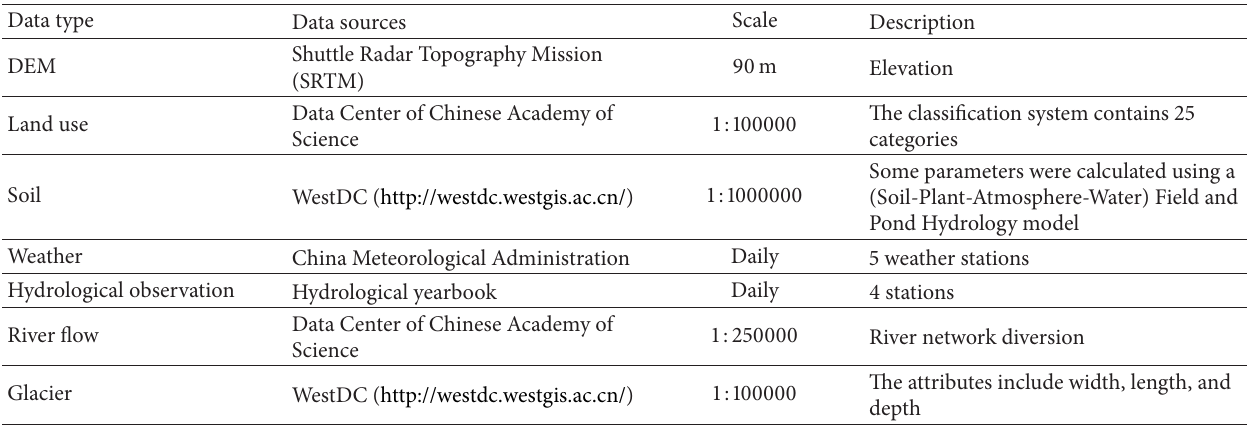
Table 1: Data used and